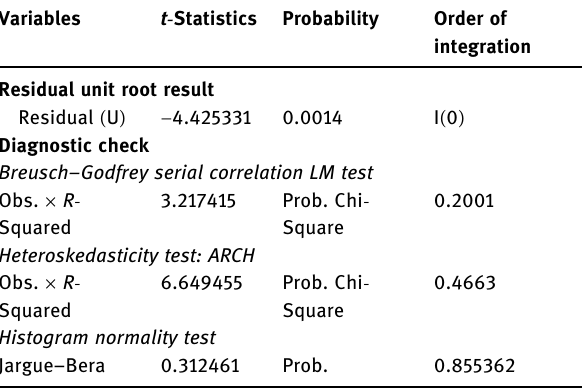
Table 5: Residual unit root result and diagnostic